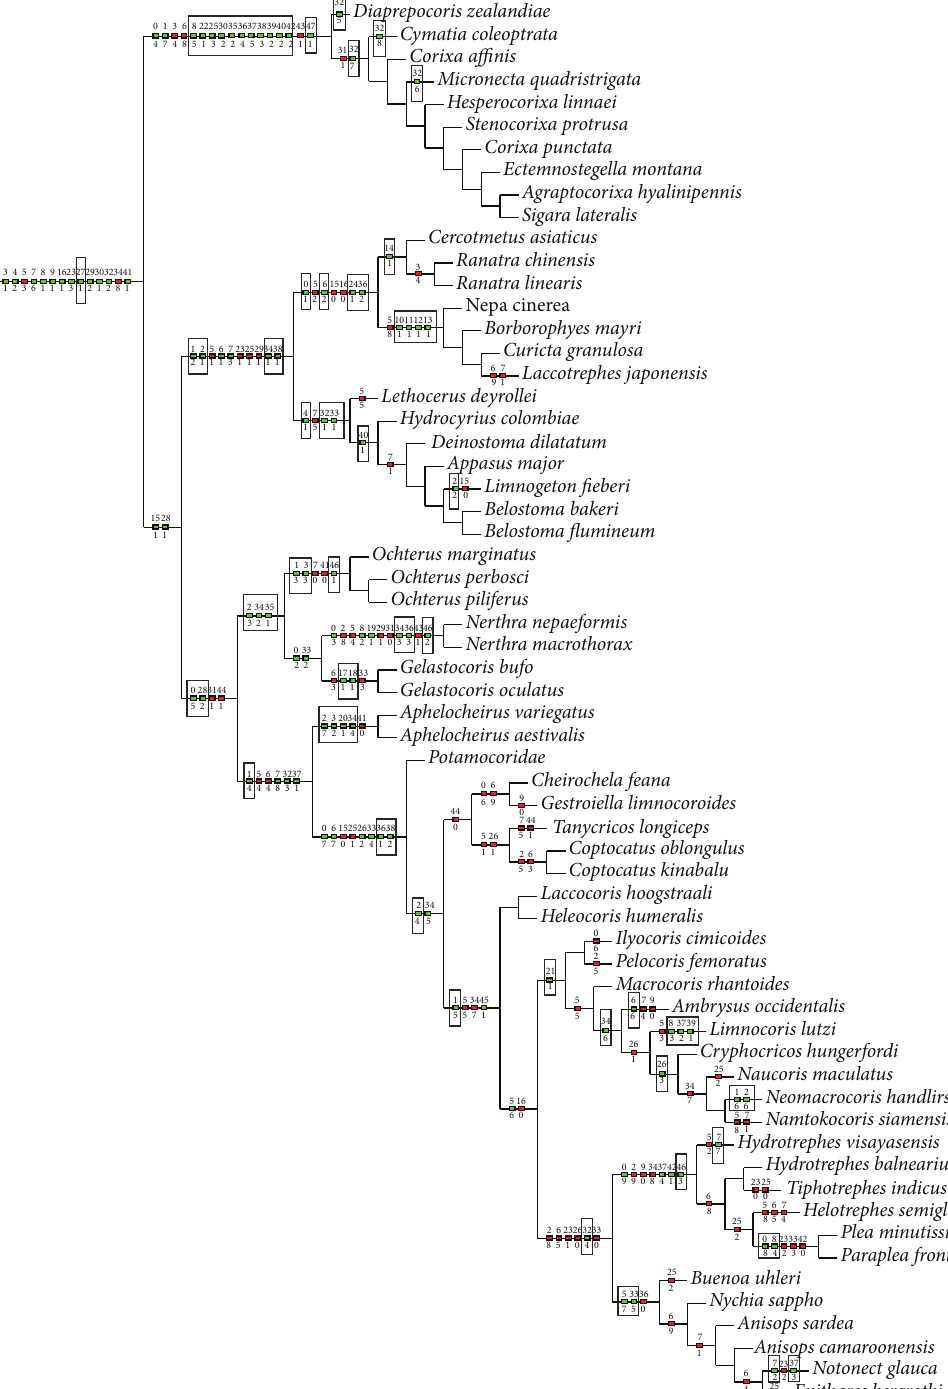
Figure 5: The most parsimonious tree resulting from the heuristic search with characters as equally weighted (tree length = 198, consistency index = 71, retention index = 92). A green box indicates nonhomoplasy; a red box indicates homoplasy. The number above the branch line refers to the number of a character; the number below the line of the branch refers to the number of the state of a character. The slow option is used (apomorphies and plesiomorphies together are